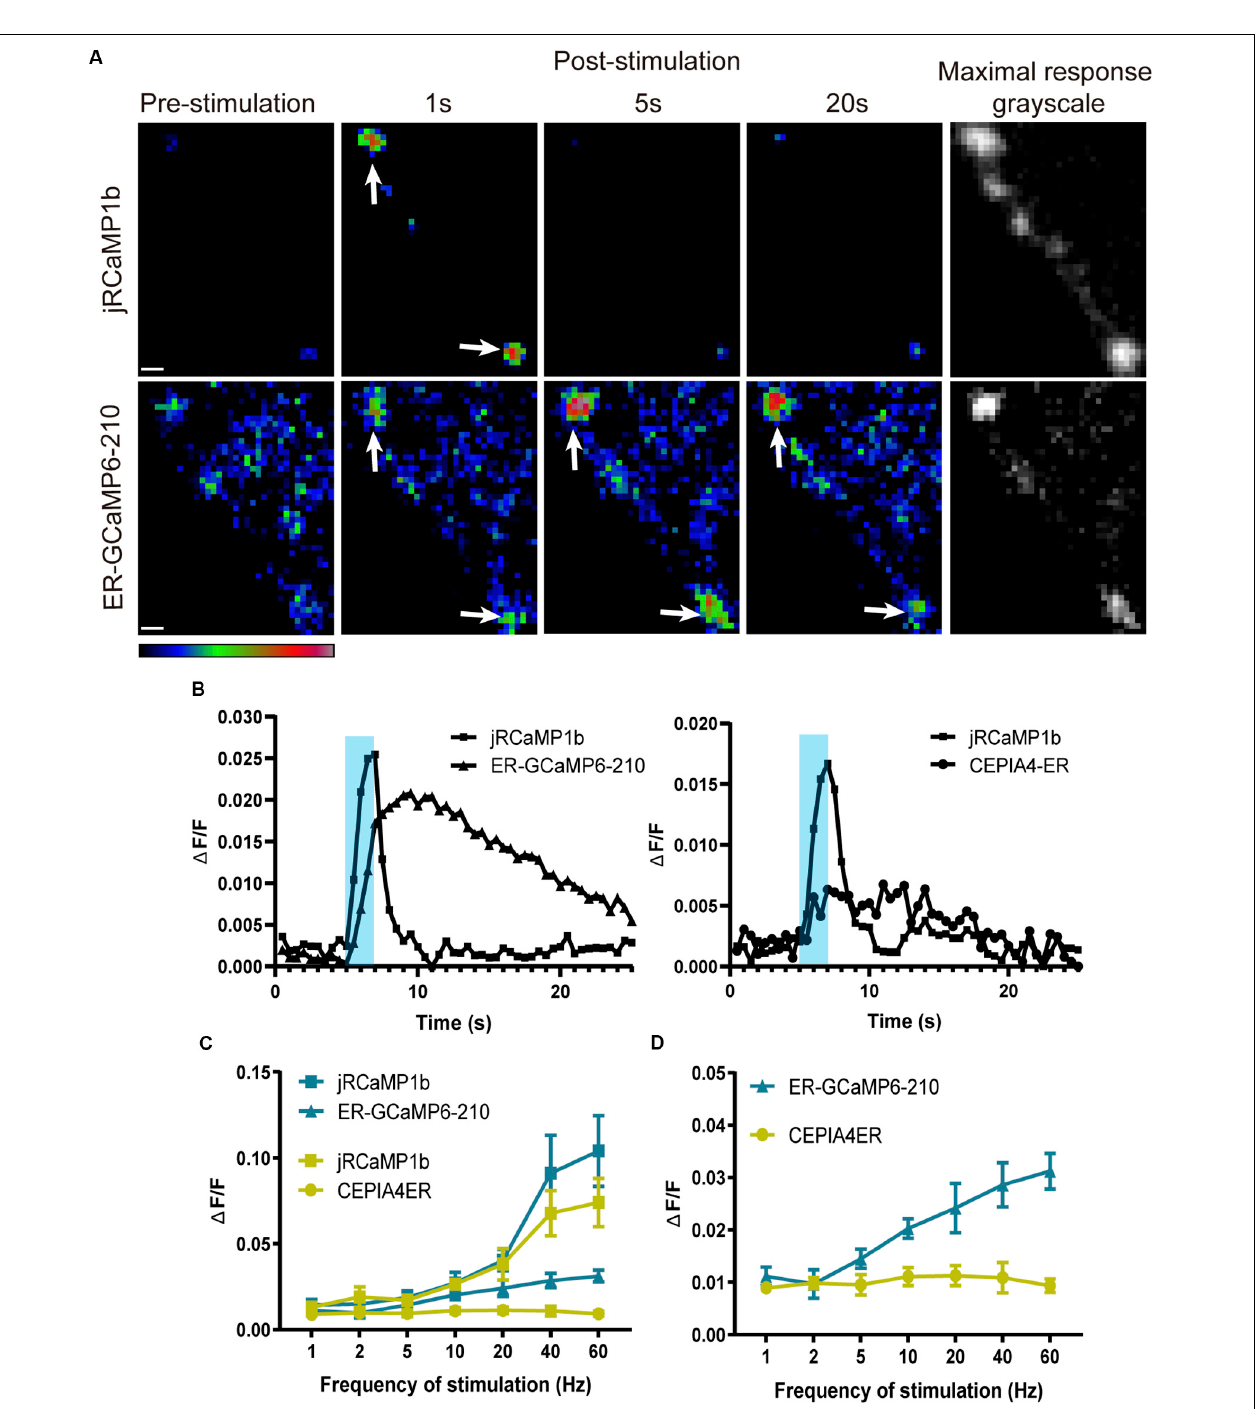
FIGURE 2 | ER lumenal Ca 2 + responses to electrical stimulation at the NMJ, visualized using ER-GCaMP6-210, were delayed and more sustained compared to cytoplasmic responses. (A) Representative pseudocolor images of responses to 40 Hz stimulation, with maximal responses shown in grayscale ( right panels ) to show position of synapse. Panels show responses of jRCaMP1b ( top row ) and ER-GCaMP6-210 ( bottom row ) at muscle 6/7, expressed in the same RP5 Type Is motor neuron using FMR-GMR27E09-GAL4 . Arrows show examples of boutons. Pseudocolor bar shows low to high relative intensity; scale bar, 2 µ m. (B) Representative responses to 20 Hz stimulation of ER-GCaMP6-210 and CEPIA4-ER with corresponding jRCaMP1b response at muscle 6/7, expressed in RP5 Type Is motor neuron using FMR-GMR27E09-GAL4 . Shading represents the stimulation period. (C) Average fold-change in peak fluorescence at different stimulation frequencies, of ER-GCaMP6-210 and CEPIA4-ER, compared with jRCaMP1b at muscle 6/7, expressed in the same RP5 Type Is motor neuron using FMR-GMR27E09-GAL4 (ER-GCaMP6-210, N = 5; CEPIA4-ER, N = 6). (D) Comparison of ER lumenal sensors only, replotted from (C) with the y -axis